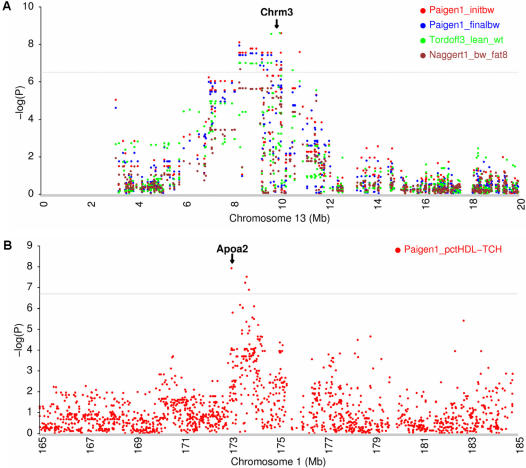
Fine mapping of Chrm3 and Apoa2.(A) Chrm3 is associated with initial body weight (7–9 weeks), day 0 of an atherogenic diet (Paigen1_initbw), final body weight after 8 weeks on atherogenic diet (Paigen1_finalbw), calculated weight of lean tissue (14 weeks) (Tordoff3_lean_wt), and body weight after 8 weeks on an atherogenic diet (Naggert1_bw_fat8) in the GWA scan. The Chrm3 region has been replicated in at least four obesity linkage studies. (B) Apoa2 is associated with percent of total plasma cholesterol in the HDL fraction after 8 weeks on an atherogenic diet (Paigen1_ pctHDL-TCH) in the GWA scan. The Apoa2 region has been repeatedly detected by linkage analyses in 12 different genetic crosses. Relevant phenotypes for these two genes were already observed in murine knockout models. The horizontal gray lines indicate genome-wide empirical thresholds.